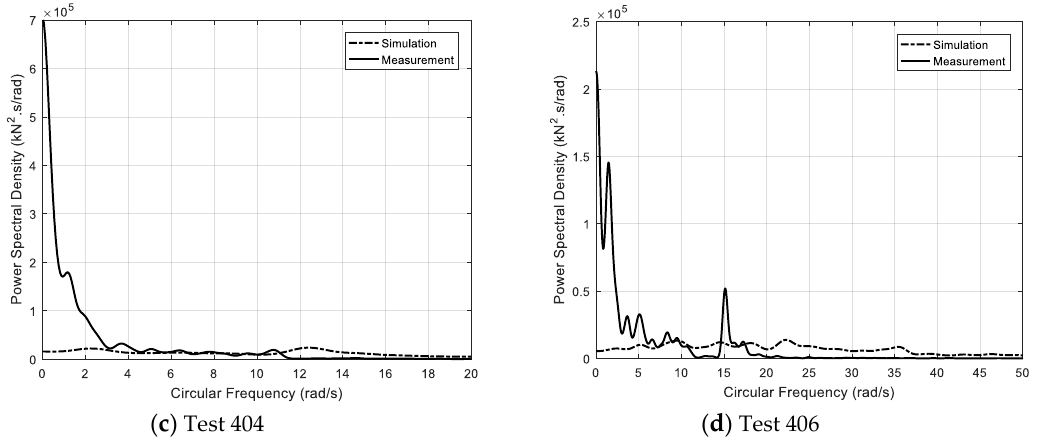
Figure 22. Spectrum of simulated and measured ice force for tests ( a ) 304, ( b ) 306, ( c ) 404, and ( d ) 406.